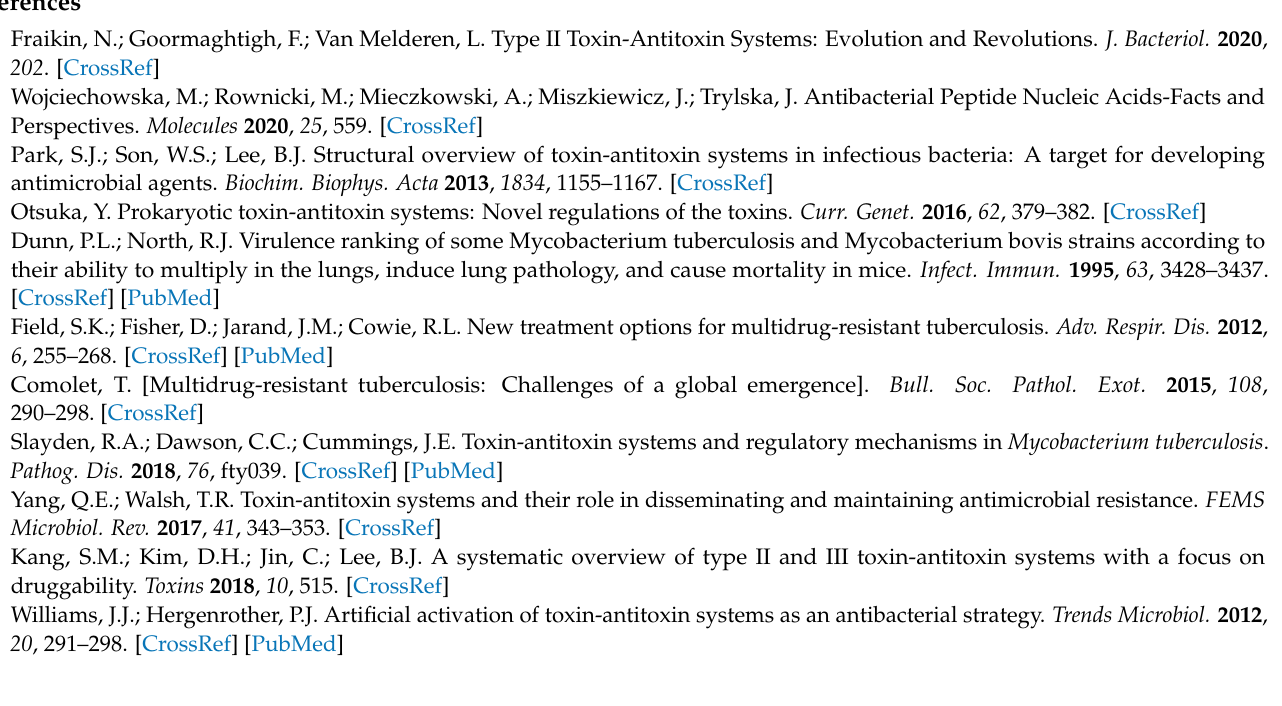
data; Figure S3: Data of the stapled peptides; Table S1: HRMS analysis of peptides; Table S2: Primers used for